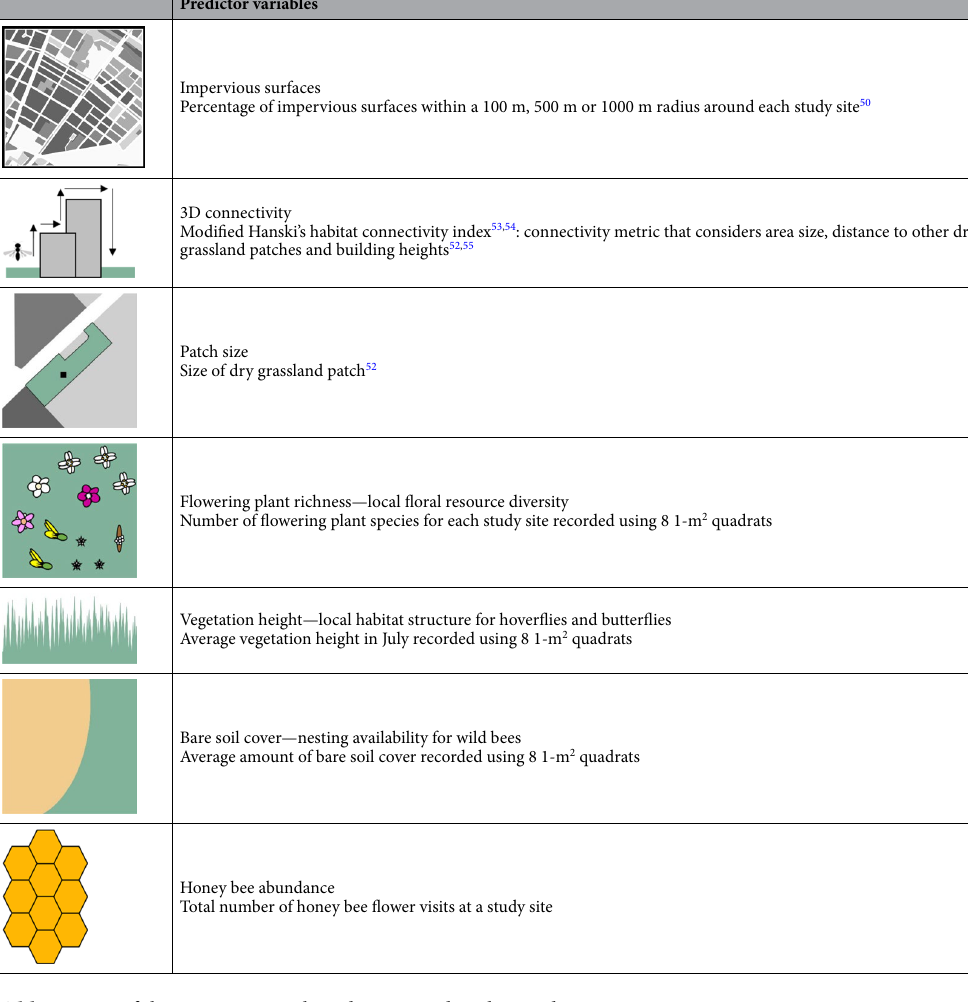
Table 1. List of the environmental predictors used in this